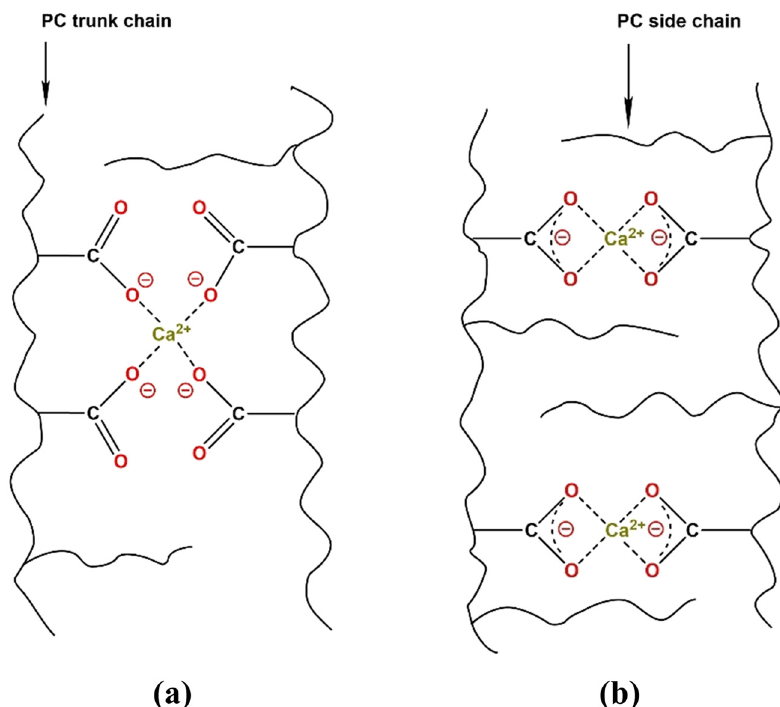
Figure 16: Schematic illustration of ( a ) monodentate complexation of Ca 2 + by two polycarboxylate ( PC ) trunk chains with low side chain density; and ( b ) bidentate complexation of Ca 2 + by two PC trunk chains with high side chain density.